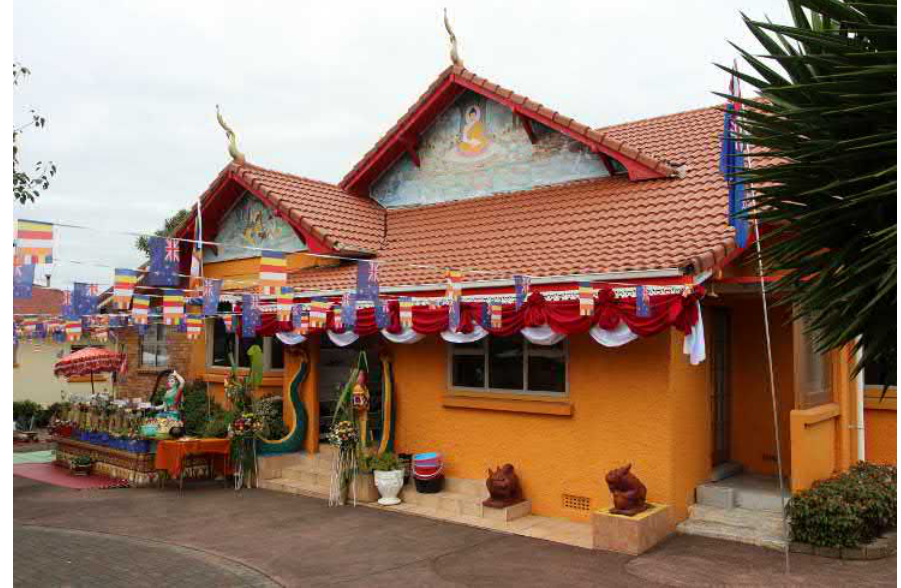
Figure 8: Laotian community in New Zealand: Wat Lao Buddharam, Ōtāhuhu, Auckland. (Photo by Vou Phommahaxay)